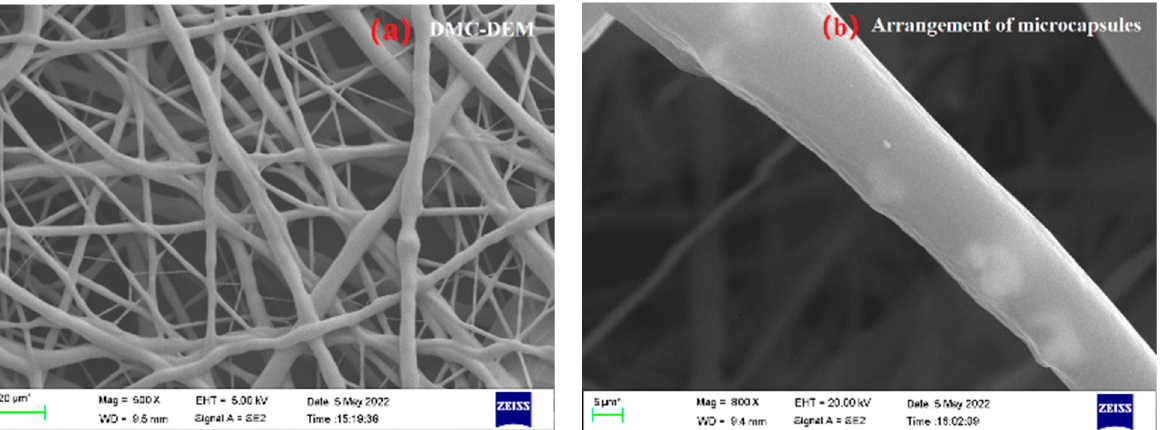
Figure 7. Arrangement trend of dielectric microcapsules in fibers. ( a ) Fiber morphology; ( b ) arrangement trend of dielectric microcapsules in fibers.